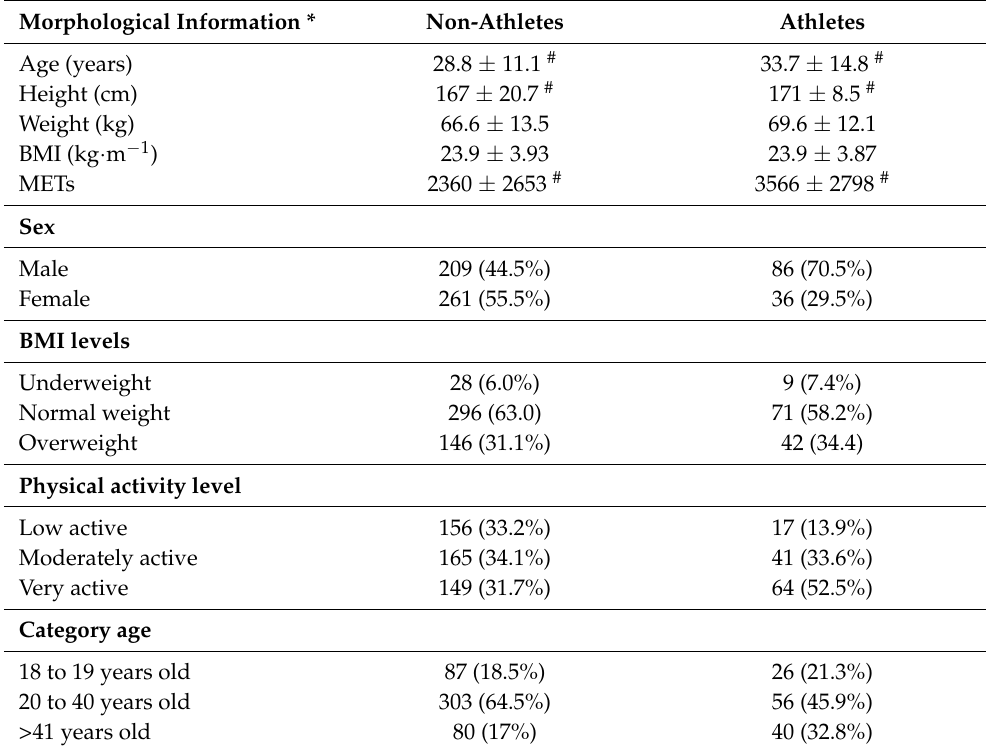
Table 1. Sociodemographic details of the non-athlete ( n = 470) and athlete ( n = 122) populations. Morphological Information *